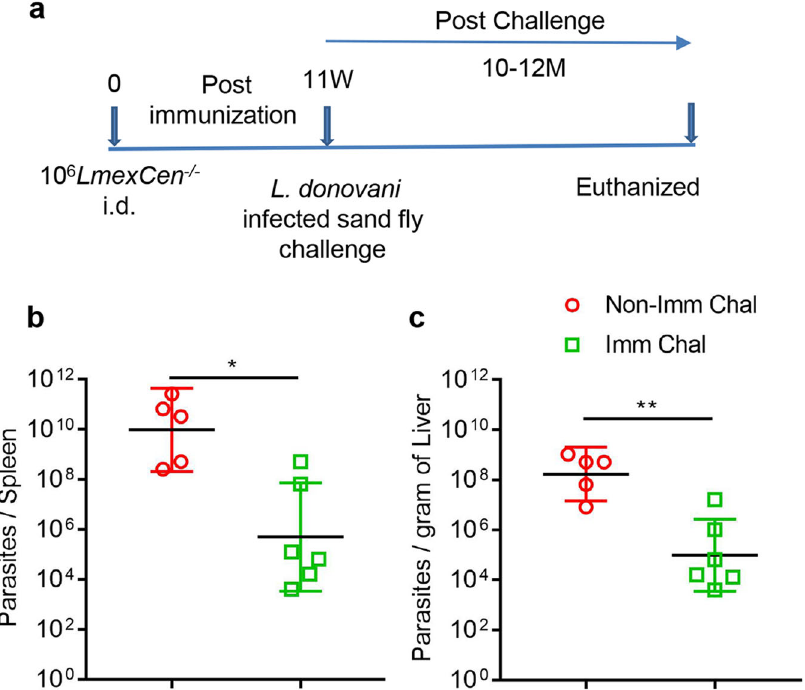
Fig. 4 LmexCen − / − immunization confers protection against sand fl y transmitted L. donovani infection in hamsters. a Schematic representation of the experimental plan. Parasite load in the spleen ( b ) and liver ( c ) of age matched non-immunized (Non-Imm chal, n = 5) and LmexCen − / − - immunized (Imm chal, n = 6) hamsters were determined after 10 – 12 months post L. donovani infected sand fl y challenge. Results represent (the geometric means with 95% Cl) one experiment (* p = 0.01 and ** p = 0.008 values were determined by Mann – Whitney two- tailed test). Results are from one experiment.